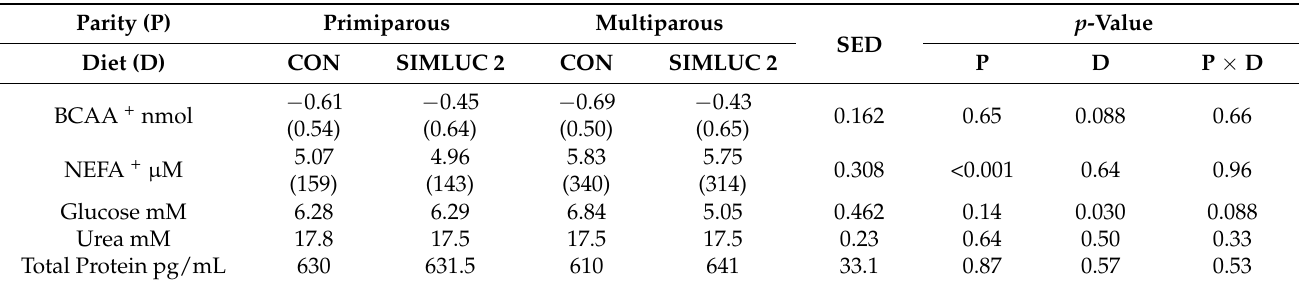
Table 5. Plasma metabolites of primiparous sows and multiparous sows fed either the control diet (CON) or SIMLUC 2 at D1